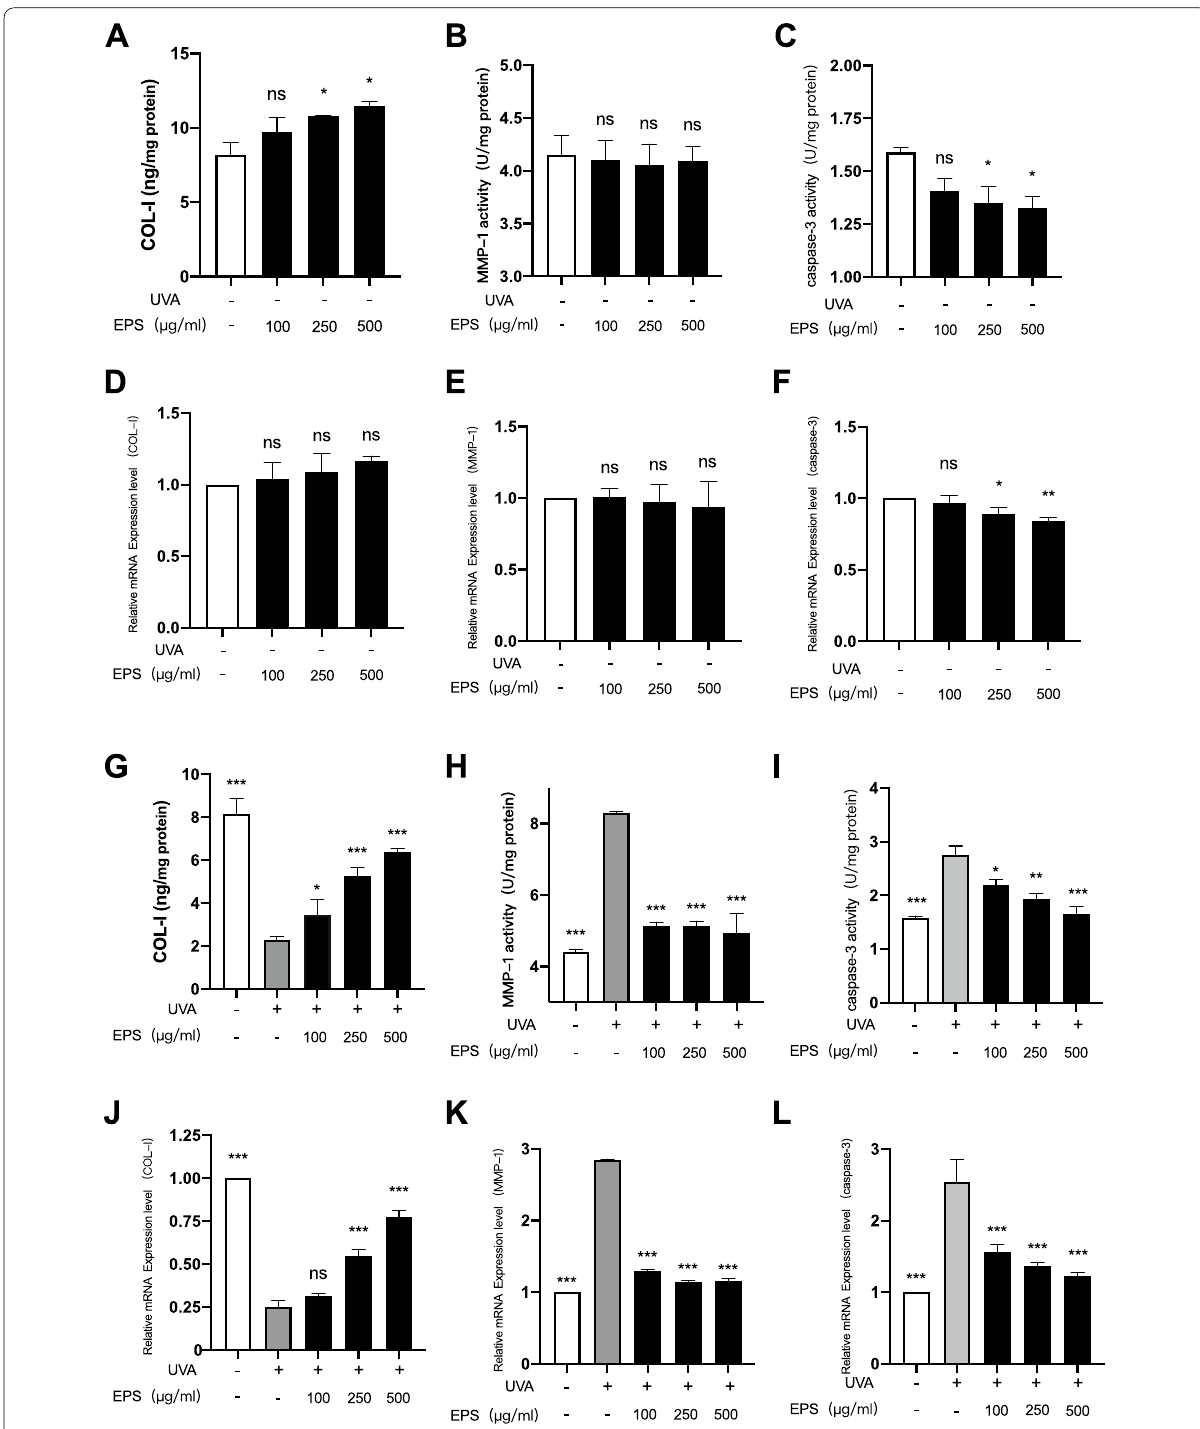
Fig. 5 Effects of different concentrations of EPS on COL-I ( A ), MMP-1 ( B ) and caspase-3 ( C ) in HSF under normal conditions. Relative expression levels of COL-I ( D ), MMP-1 ( E ) and caspase-3 ( F ) mRNA in HSF under normal conditions with different concentrations of EPS. Effects of different concentrations of EPS on COL-I ( G ), MMP-1 ( H ) and caspase-3 ( I ) in HSF under UVA irradiation. Relative expression levels of COL-I ( J ), MMP-1 ( K ) and caspase-3 ( L ) mRNA in HSF under UVA irradiation with different concentrations of EPS.Each mRNA was referenced to the internal control gene β-actin and expressed relative to the control group. * p < 0.05, ** p < 0.01, *** p < 0.001 compared to model